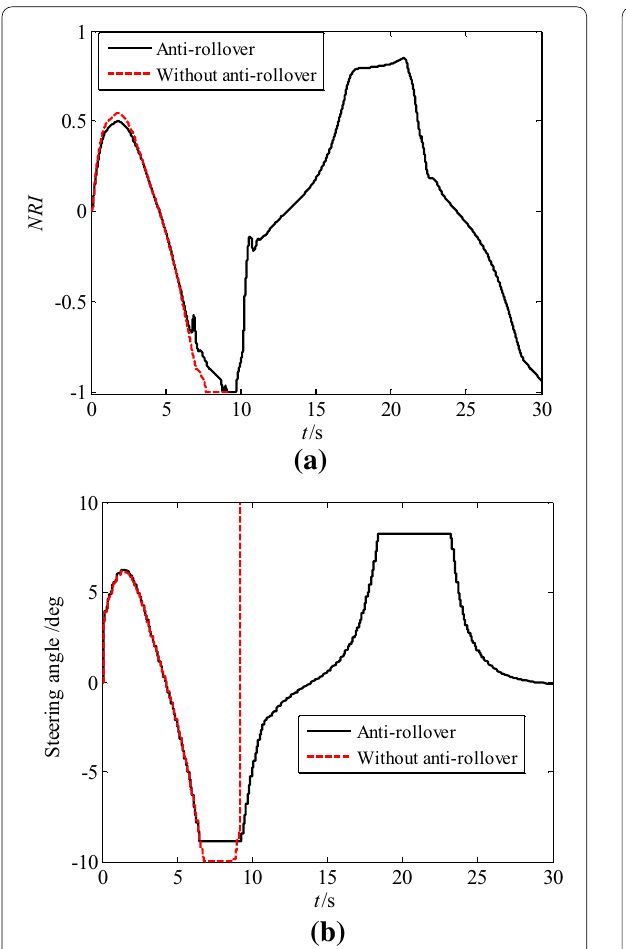
Figure 15 Rollover stability of the intelligent heavy truck in Scenario